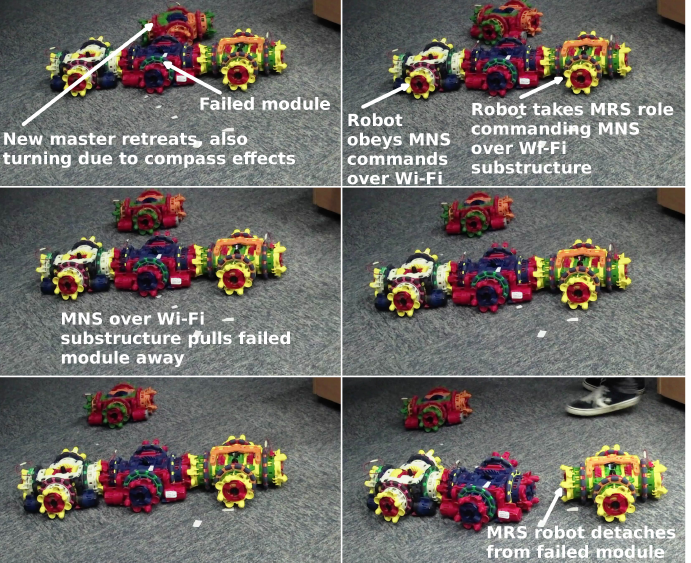
Figure 17. Neighbouring robots attempt to manoeuvre a failed module, whilst the new master